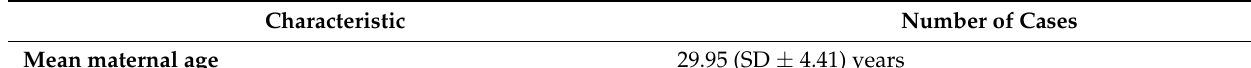
Table 1. Demographic and clinical characteristics of the patients included in the